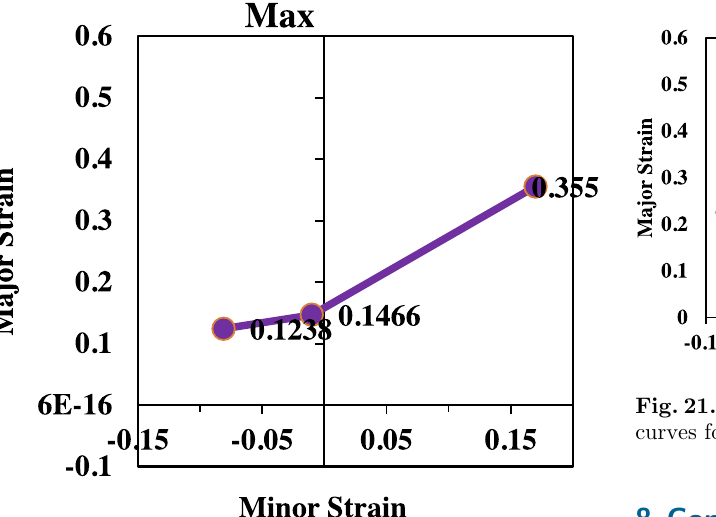
Fig. 19. Forming limit diagram for isotropy (cid:4) numerical simulation.